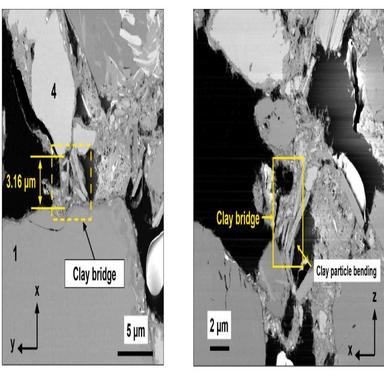
Clay bridge. (a) and (b) Selected FIB-SEM slices showing a clay bridge (linking Particles 1 and 4) in x-y and x-z plane respectively. (c) and (d) 3D visualization of the internal structures of the bridge from two view angles. A bent flaky particle within the clay is shown in (b) and (d).